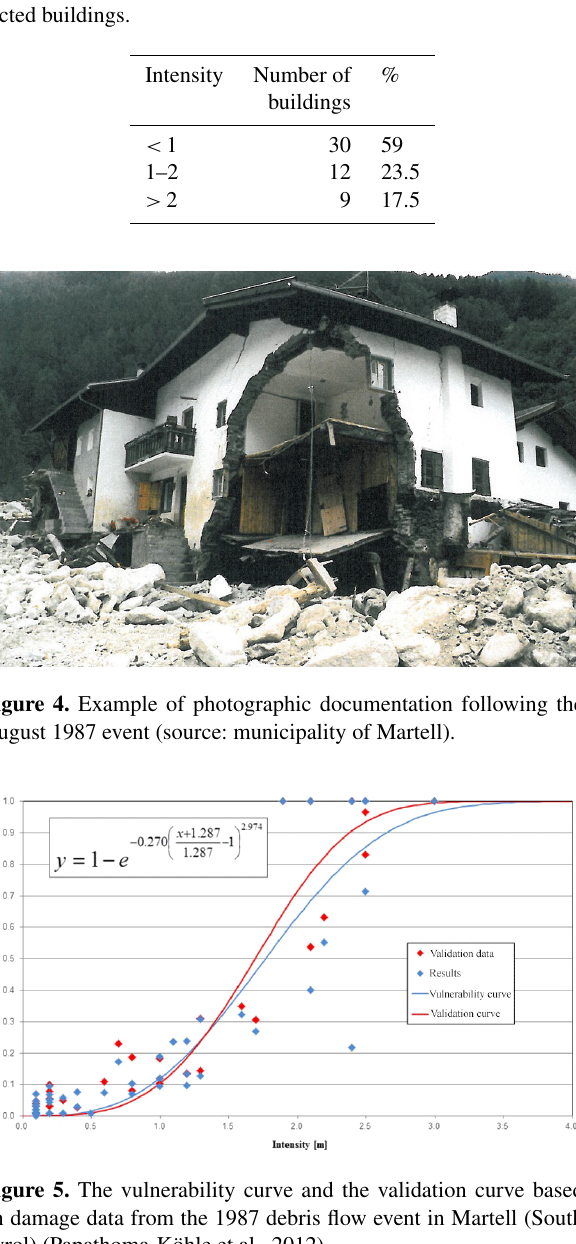
Table 1. Intensity categories and the corresponding number of af- fected buildings.